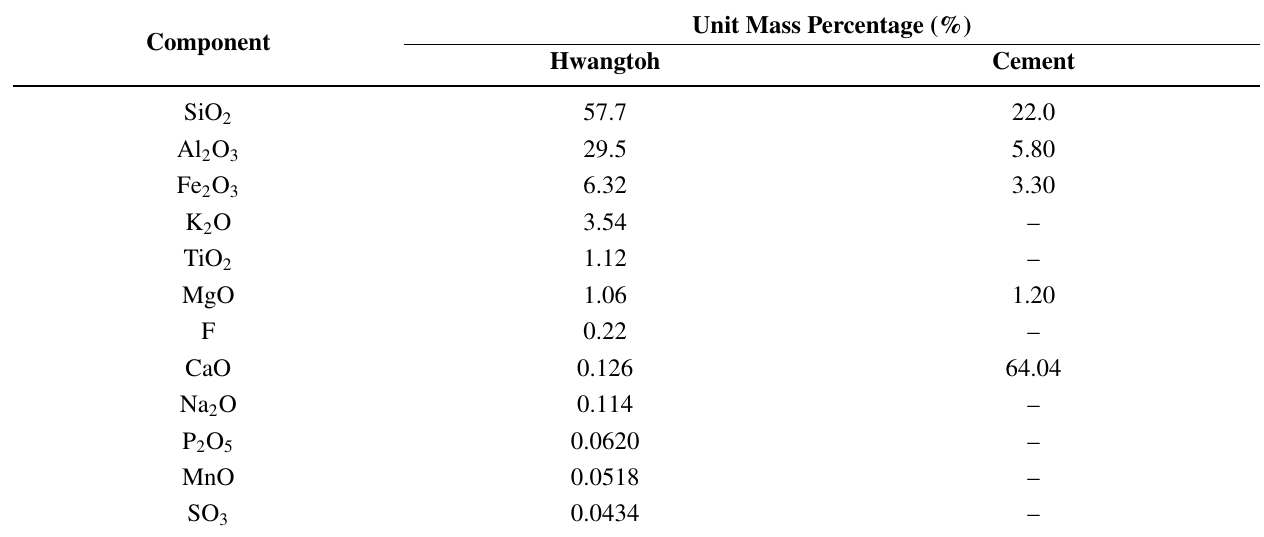
Table 1. Chemical composition of activated Hwangtoh and